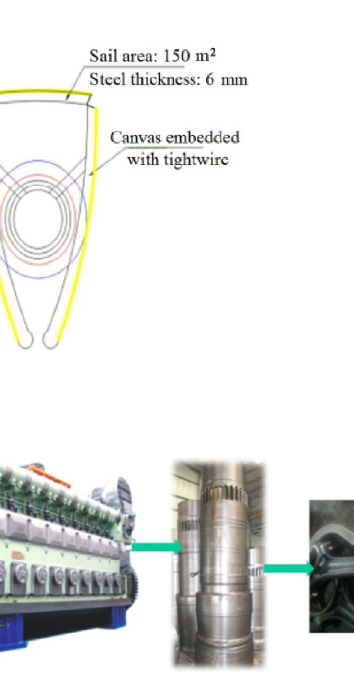
Fig. 7 Main engine, cylinder, and piston with carbon deposits.